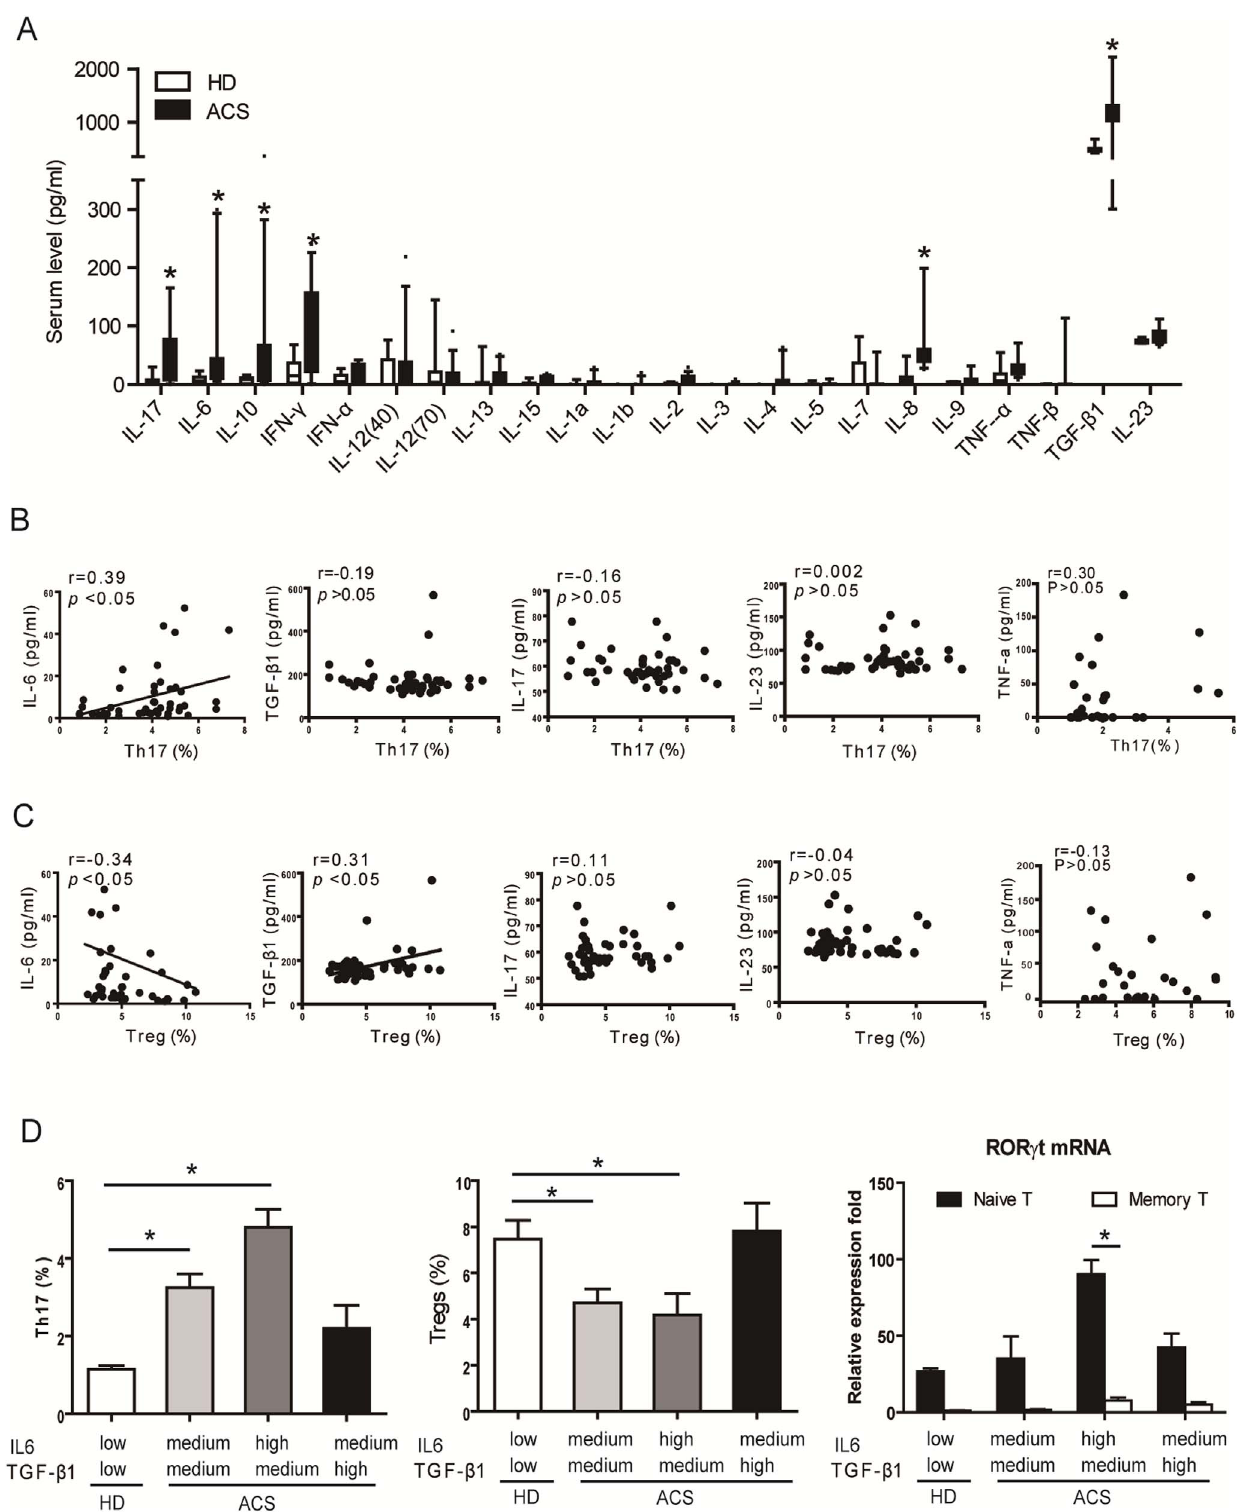
Figure 2. Pro-inflammatory cytokines regulate Treg and Th17 cell differentiation. (A) The levels of pro-inflammatory cytokines in the sera of healthy donors (n=25) and ACS patients (n=51) were determined by high-sensitivity multiplex assays. The results are shown as the median (10–90 percentiles). (B) Individual frequencies of Th17 cells positively correlate with circulating IL-6 levels in patients with ACS (n=51). The TGF- b 1, IL17 and IL23 levels were not associated with the frequency of Th17 cells. Correlations were determined by Spearman’s rank correlation coefficients. The relationships are also depicted using linear regression (solid line). (C) Circulating IL-6 levels negatively correlate with the proportion of Treg cells. In addition, TGF- b 1 concentrations positively correlate with the proportion of Treg cells. (D) Comparisons of the frequencies of Th17 and Treg cells in